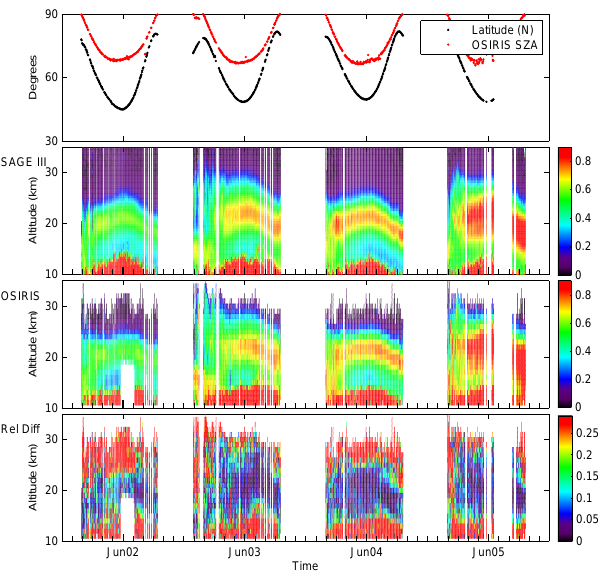
Fig. 7. The daily zonal average OSIRIS aerosol extinction ratio for the SAGE III time period for the following latitude bands shown from top to bottom: 55–65 ◦ N, 15–25 ◦ N, 15–25 ◦ S, and 55–65 ◦ S. Periods when sunlit measurements are not possible due to solar zenith angle greater than 90 ◦ or when OSIRIS was turned off for engineering tests are indicated in